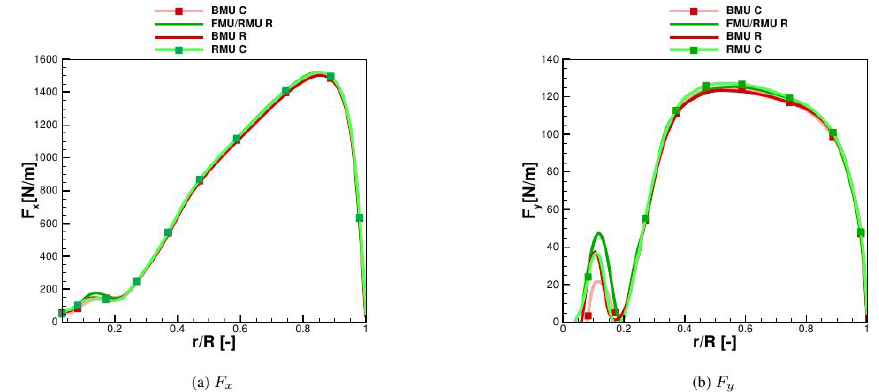
Figure 7. Sectional loads for BMU vs. RMU: comparison between rigid (R) and coupled (C) calculated with CFD at 6.1ms − 1